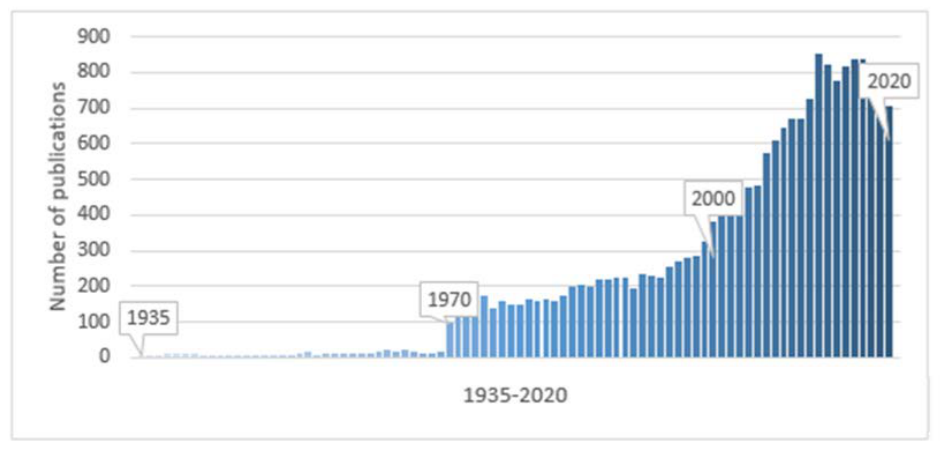
Figure 7. Number of publications involving QACs from 1935 to 2020 (SciFinder, January 2021).